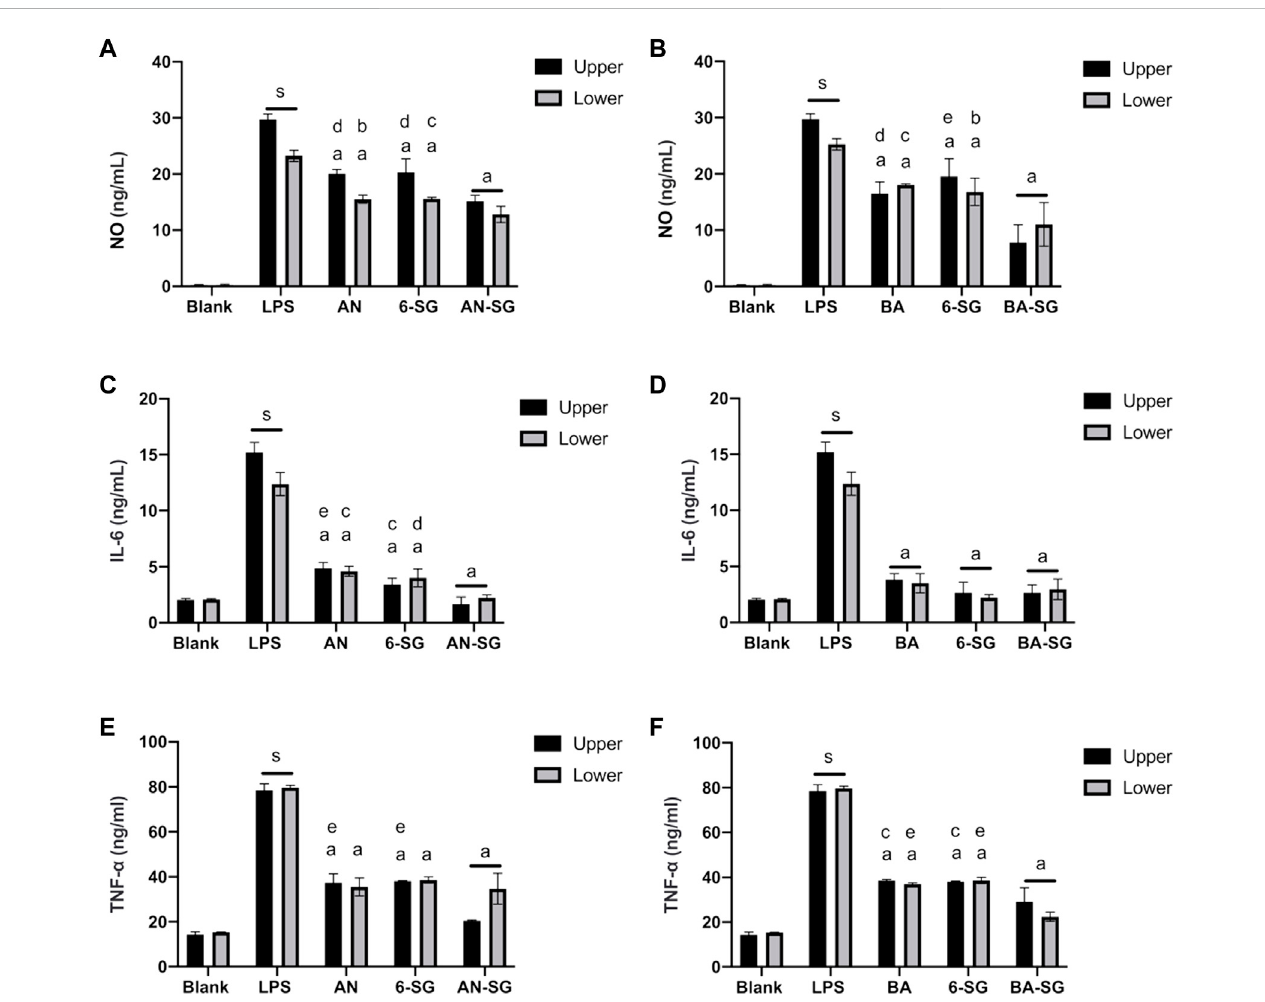
AN-SG and BA-SG generally exhibited greater effects in reducing nitrite, IL-6 and TNF- α productions than that of the individual component in the tri- culture system. AN-SG inhibited nitrite (A) , IL-6 (C) , and TNF- α (E) productions and BA-SG inhibited nitrite (B) , IL-6 (D) and TNF- α (F) productions in LPS- activated tri-culture model in both upper and lower compartments. Data are shown as mean ± SEM ( n = 3). Figures generated by Graphpad prism 9.0. The statistical comparison between groups was conducted by one-way ANOVA analysis and Tukey test for group comparison. s: p < 0.0001 vs. Blank, a: p